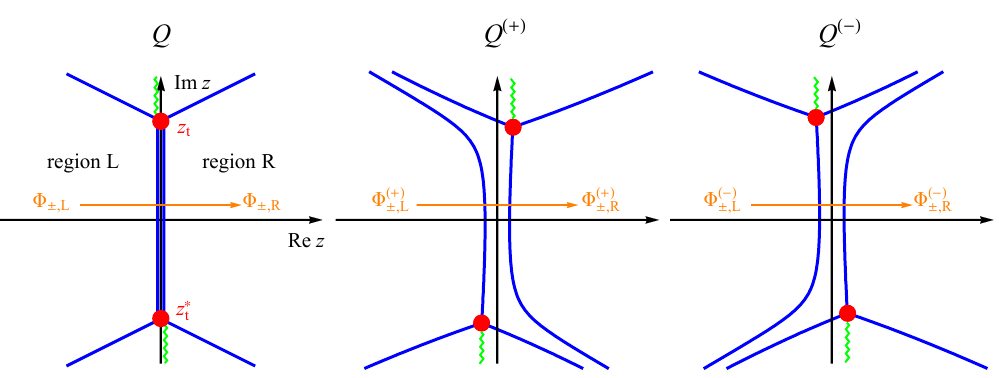
Figure 2 . (color online) De-degeneration of a Stokes segment C z Q ( ± ) (3.21). Turning points, Stokes lines, and branch cuts are represented by the red points, blue lines, and green wavy lines, respectively. The Stokes segment C z blue line in the left most